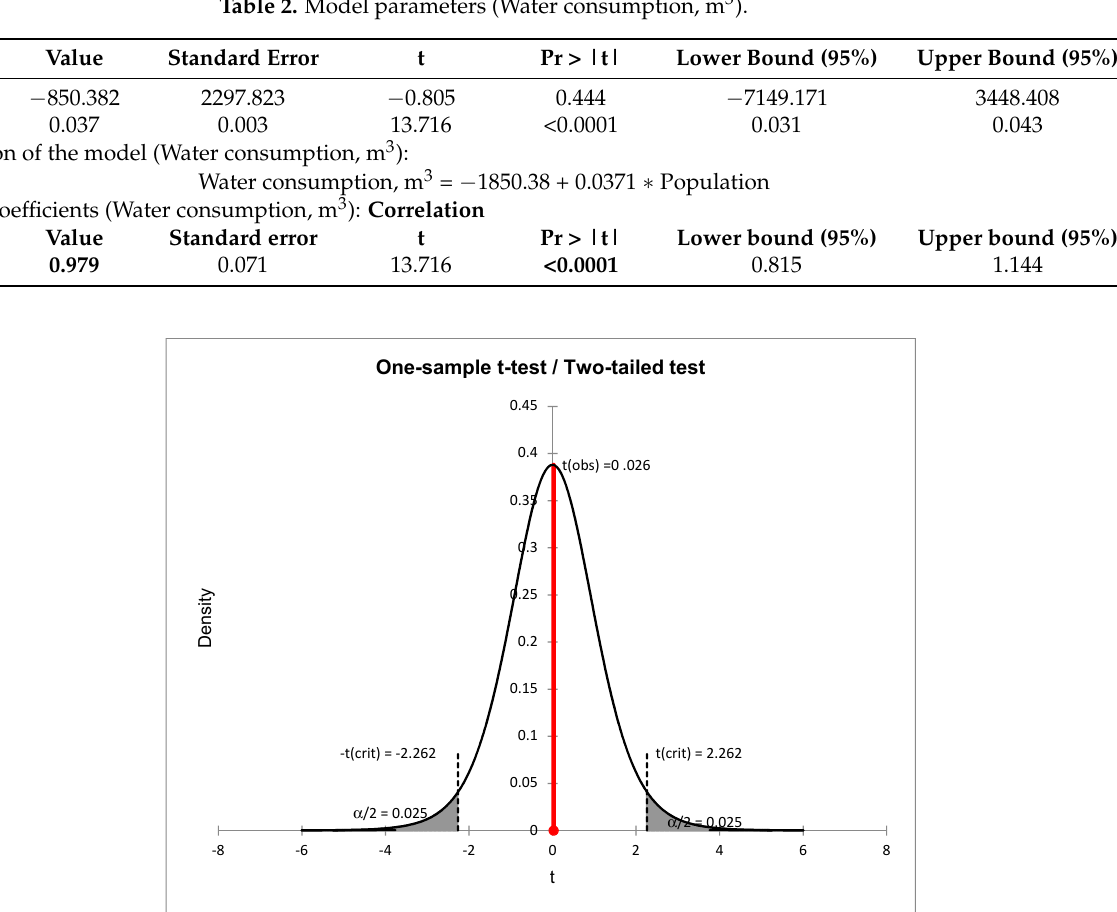
Table 2. Model parameters (Water consumption, m 3 ).